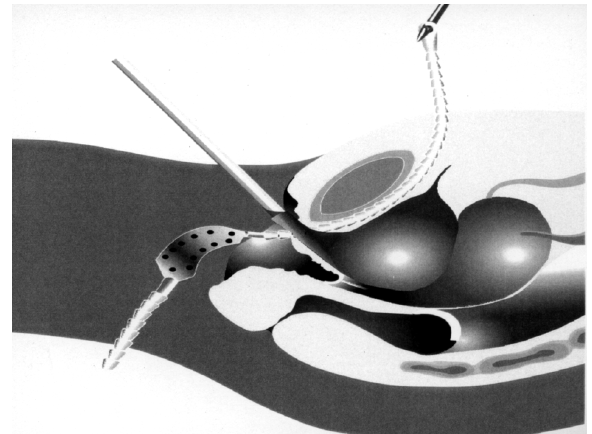
Figure 3 - SAFYRE TM is attached to the needle and pulled out to the suprapubic